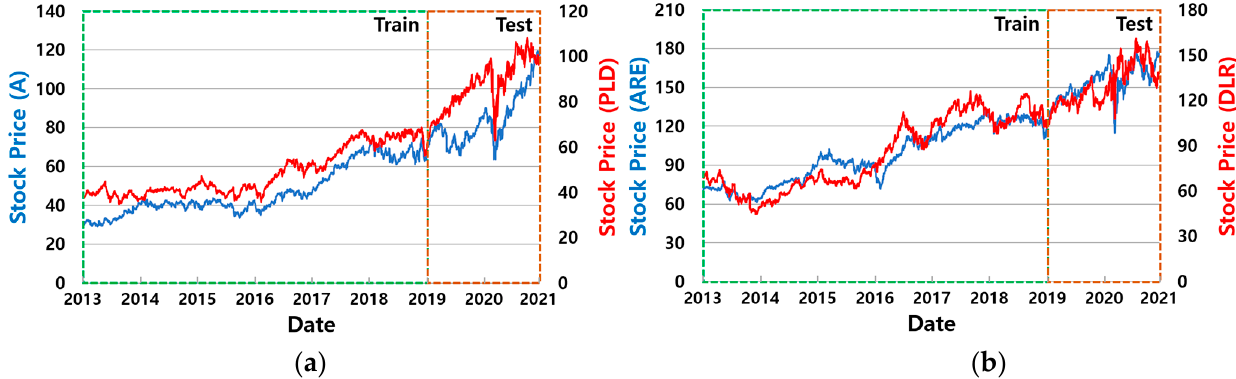
Figure 9. Stock pairs trending upward. ( a ) A, PLD. ( b ) ARE, DRL.